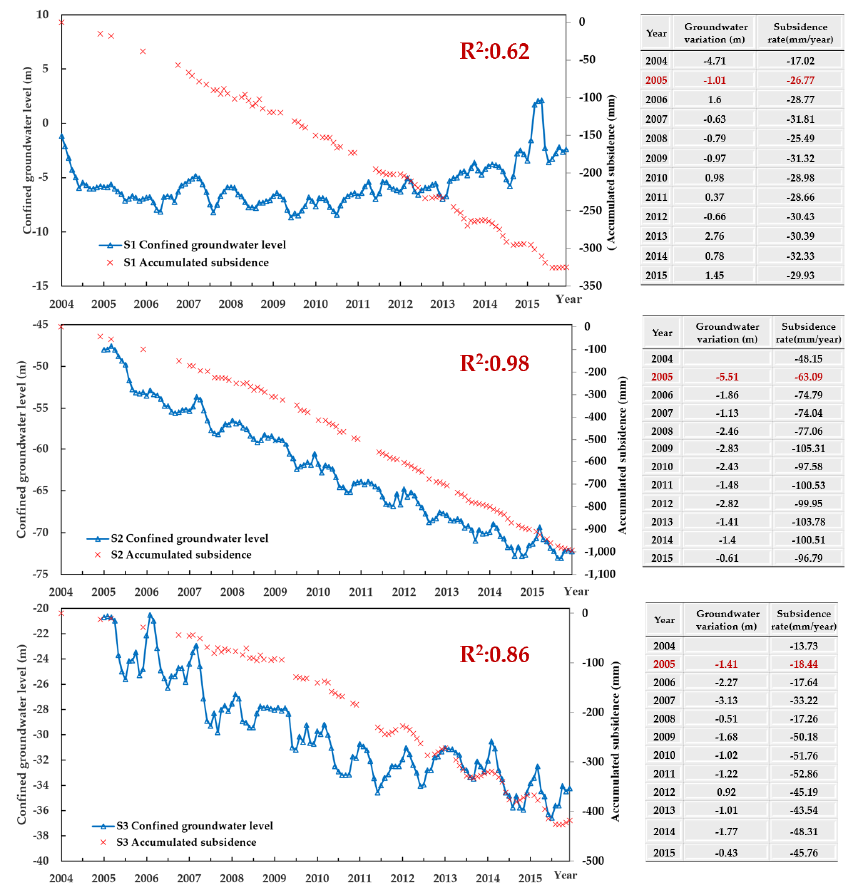
Figure 9. Response relationship between confined water level and land subsidence from 2004 to 2015 (subsidence mutation occurred in 2005).